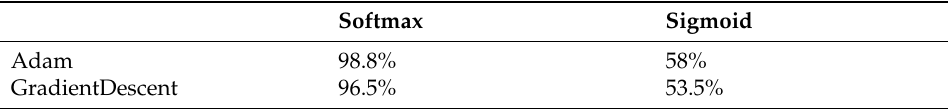
Table 4. Accuracy corresponding to different combinations.